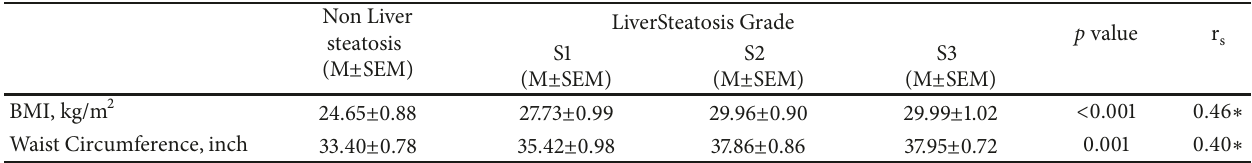
Figure 2: ROC Curve using CAP and Fragmented CK-18, to predict liver steatosis in US. Figure 2 showed CAP value with cutoff value of 263dB/m and 319dB/m had good sensitivity and specificity. FragCK-18 with cut-off value of 194U/L and 345 U/L had a good sensitivity to predict moderate-severe steatosis. Table 2: Relationship between anthropometric data with liver steatosis as assessed by US. BMI: Body Mass Index; M: means; SEM: standard error or means.r 𝑠 : Spearman coefficient correlation; ∗ :